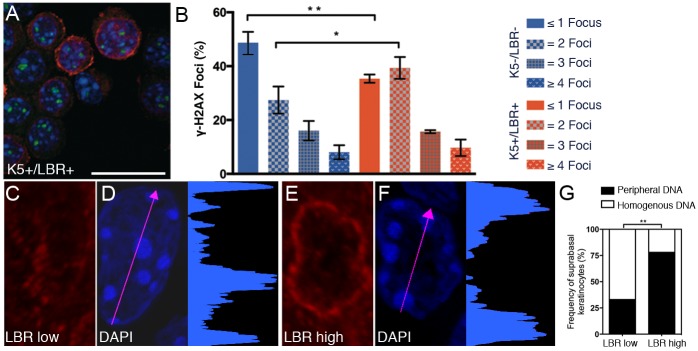
Increased DNA damage-related foci and peripheral DNA localization is associated with LBR overexpression.A-B. Primary keratinocytes from week-13 K5+/LBR+ (a) and K5-/LBR- mice were analyzed for the frequency of γH2AX foci (green), LBR (red) and DAPI (blue). C-F. The intensity profile of DAPI staining in suprabasal cells of the paw skin was examined in week-8 K5+/LBR+ mice. Cells that did not express LBR had a more homogenous intensity (C-D), whereas increased intensity of DAPI staining was seen at the nuclear periphery in cells that expressed LBR (E-F). D and F. The graph indicates fluorescence intensity of DAPI staining along the arrow. The histograms show the measured DAPI intensity. LBR (red). G. Quantification of the frequency of DNA distribution in LBR expressing (LBR high) and non-expressing (LBR low) cells of the suprabasal keratinocytes. Scale bar indicates 20 μm. *p<0.05, ** p<0.01.